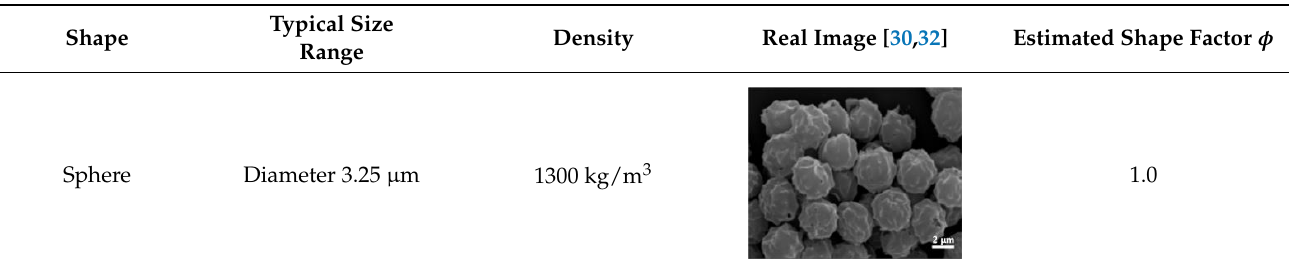
Table 1. Shape image of Aspergillus niger spores. Typical Size Shape Range